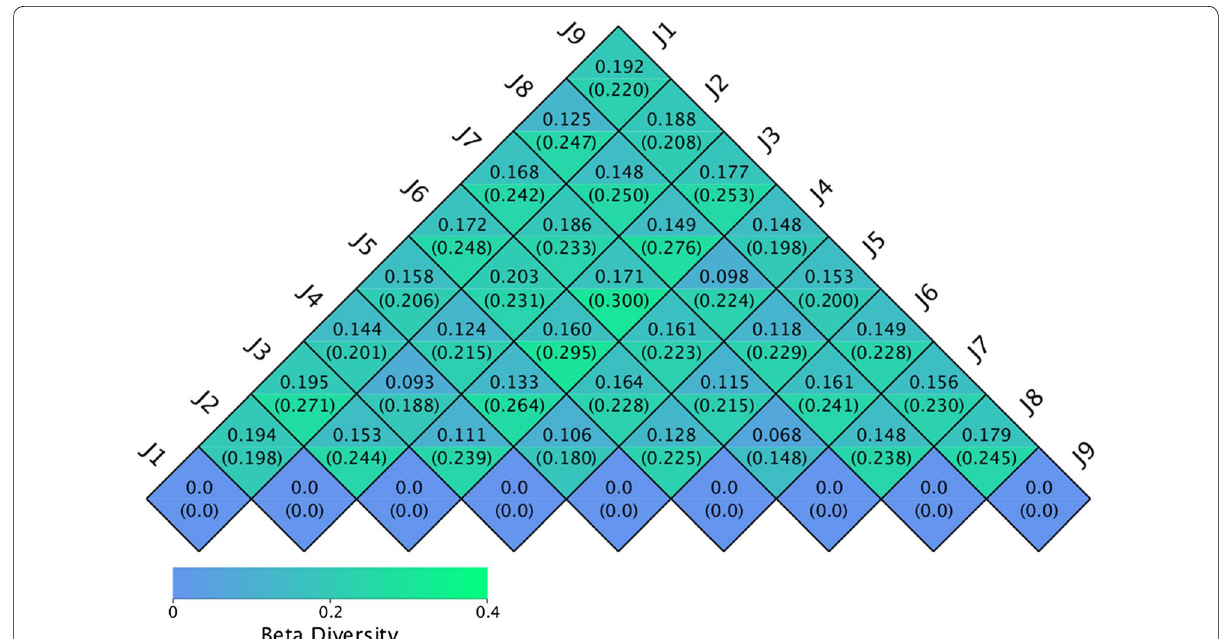
Fig. 5 Heatmap of Weighted Unifrac and Unweighted Unifrac distances. In the same square, a fluctuation in two values indicates the Weighted Unifrac and Unweighted Unifrac distances. The number in the diagram pane is the discrepancy coefficient between any two samples. The smaller the discrepancy coefficient between two samples, the smaller the difference in species diversity